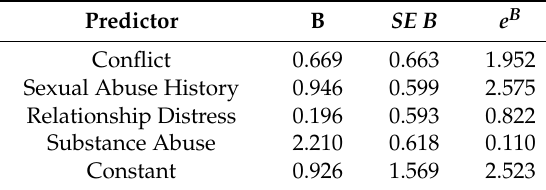
Table 1. Summary of Logistic Regression Analyses in model that did not include victim report.